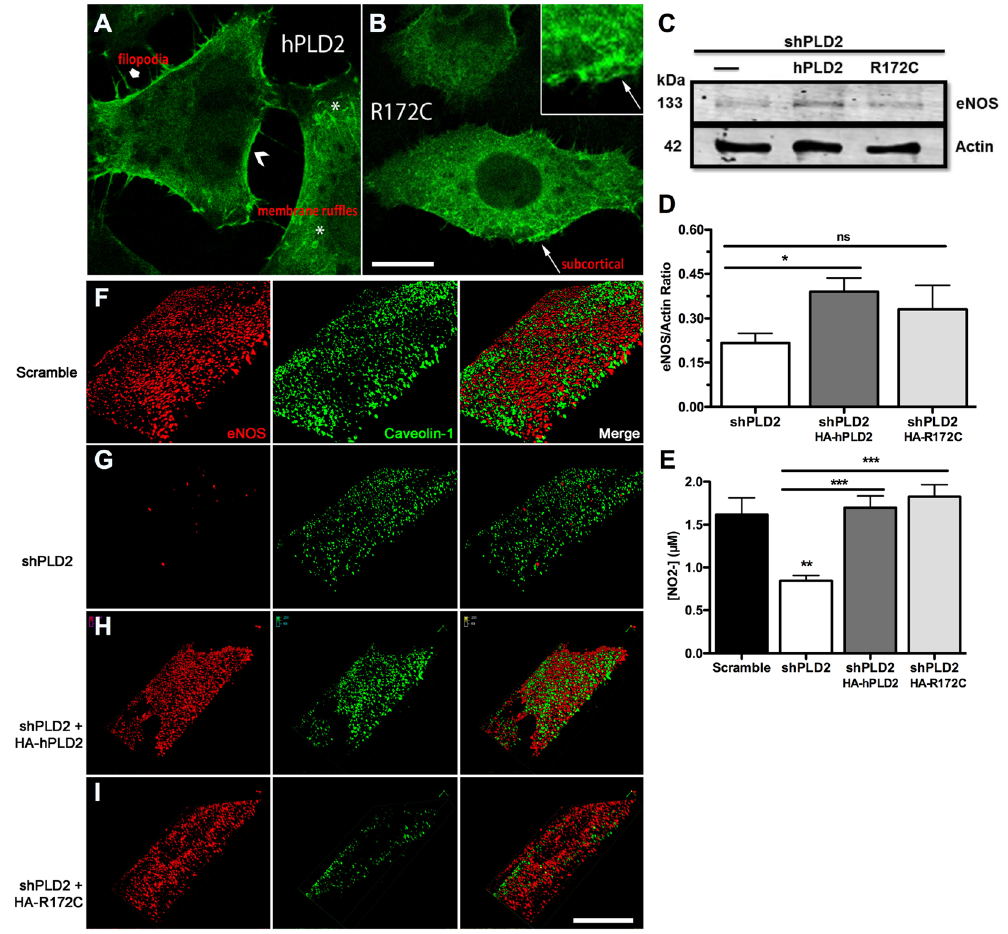
Figure 7. The human PLD2 polymorphism R172C does not alter eNOS signaling but does decrease caveolin-1 protein levels. Overexpression of HA-tagged hPLD2 ( A ) and HA-R172C-PLD2 ( B ) in HeLa cells, visualized using anti-HA immunofluorescent staining (green). Arrowhead, PLD2 localization in filopodia; chevron, in peripheral actin ruffles; * , in dorsal actin ruffles; arrow, in subcortical actin network. Bar, 7.5 μ M. Representative image of multiple experiments. ( C ) Representative western blot of eNOS after transfection of HA-hPLD2 or HA-R172C-PLD2 into shPLD2 cells. The regions of the Western blots containing the eNOS and actin immunoreactive bands were scanned and the relative abundance of the individual samples quantified using an Odyssey CLx imaging system. ( D ) Quantification of western blotting with eNOS levels normalized to actin (n = 3). ( E ) eNOS activity as measured by nitrate formation (n = 7). Lane 1 vs 2, P = 0.0021; lane 2 vs 3, P = 0.00035; lane 2 vs 4, P = 0.00012. ( F–I ) N-SIM microscopy of plasma membrane eNOS and caveolin-1. Bar, 7.5 μ M. Representative image of multiple Scramble or shPLD2 cells imaged. Cells in H and I were selected for imaging based on expression of HA-hPLD2 or HA-R172C-PLD2 as visualized by anti-HA immunofluorescence in a separate channel (not shown). Mean ± SEM; * p < 0.05; ** p < 0.01; *** p ≤ 0.001; One-way ANOVA with Bonferroni’s Multiple Comparison